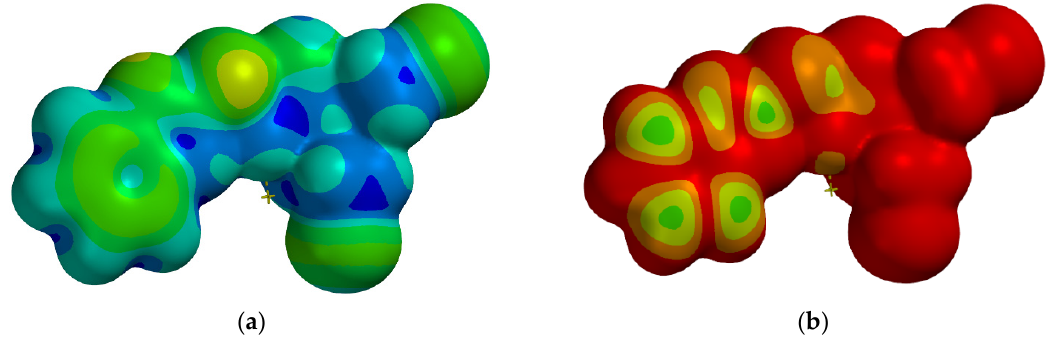
Biomedicines 2021 , 9 , x FOR PEER REVIEW Figure 7. Local ionization map ( a ) and |LUMO| map ( b ) for molecule IX. Figure 7. Local ionization map ( a ) and |LUMO| map ( b ) for molecule IX.